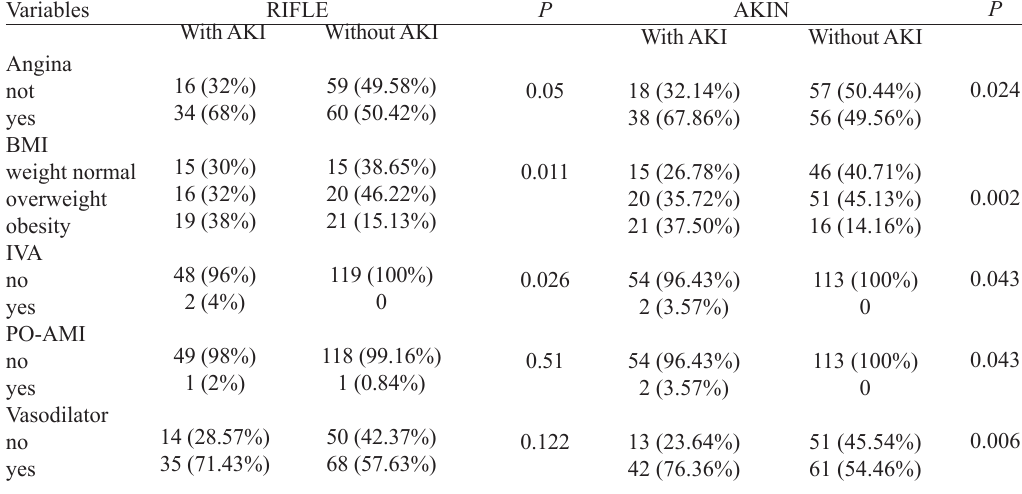
Table 4. Relationship of clinical variables and anthropometric ratings from